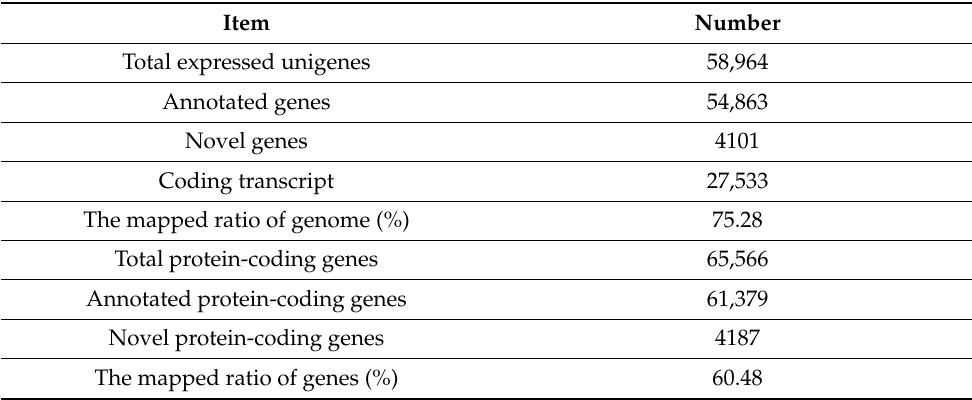
Table 5. Summary of novel genes and genomes.